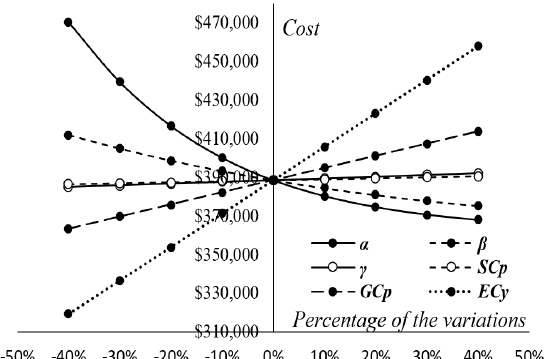
Figure 11. The Impacts of Related Parameters α , β , γ , SC p , EC p y and GC p on the Cost.